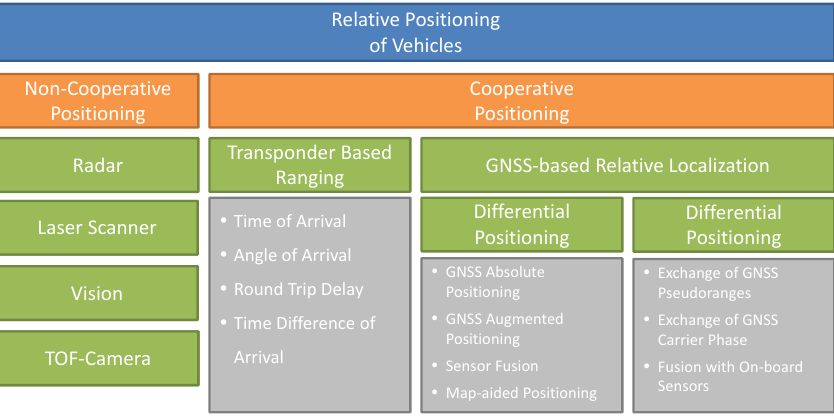
Figure 1. Technologies for relative positioning of vehicles. In this work, we differentiate between non-cooperative and cooperative